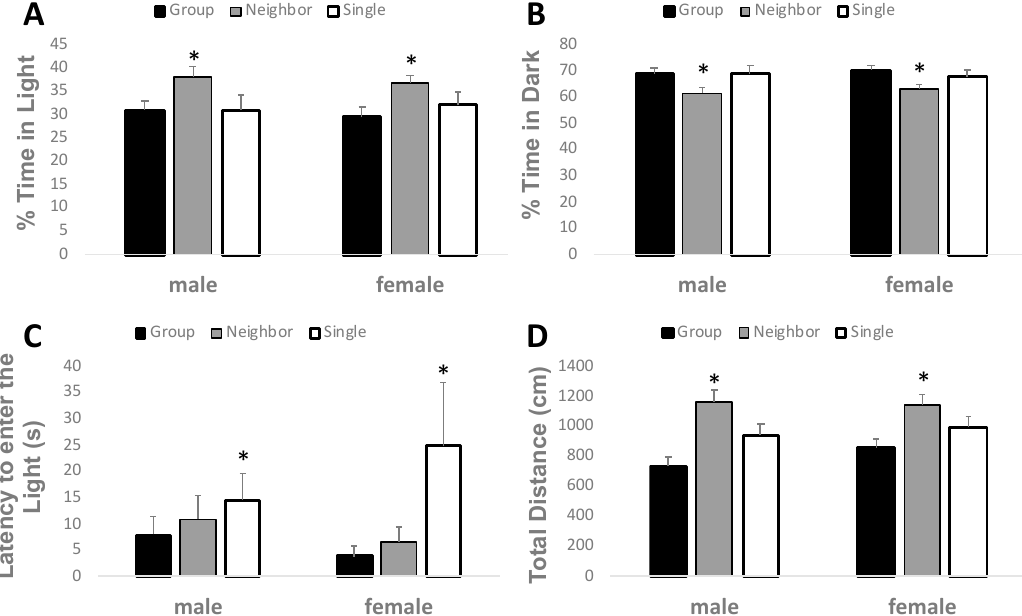
Figure 5. Neighbor housing reduces anxiety-like behavior in the light dark box. Percent time in the light ( A ), percent time in the dark ( B ), and total distance travelled ( C ) were significantly increased in neighbor housed mice as compared to group or single housed mice, ( D ) The latency to enter the light was significantly increased by single housing. * p < 0.05 versus the other two housing conditions by two-way ANOVA main effect of housing.